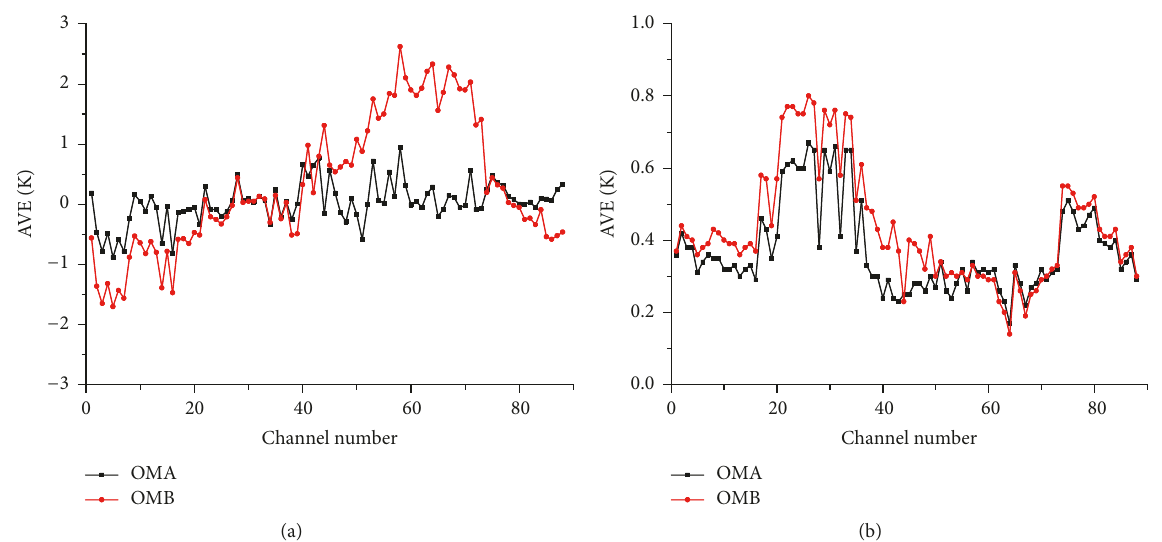
Figure 10: The AVE of OMA and OMB from each channel of the AIRS test and the AIRS_GRD test.